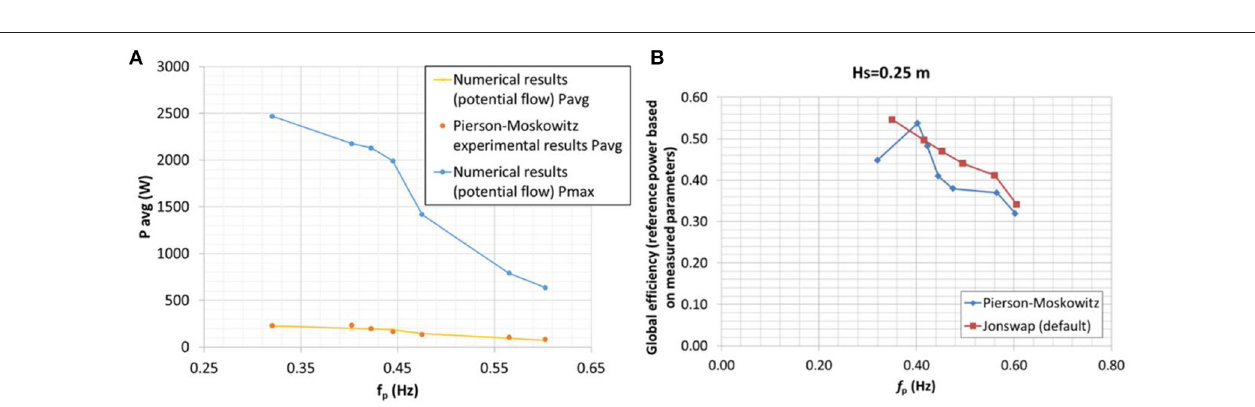
FIGURE 13 | Comparison between measured average and max mechanical power for irregular sea states, for constant significant height (H s = 0.25m) and variable peak frequency (Pierson Moskowitz spectrum) (A) . Global measured conversion efficiency, for irregular sea states (B) .